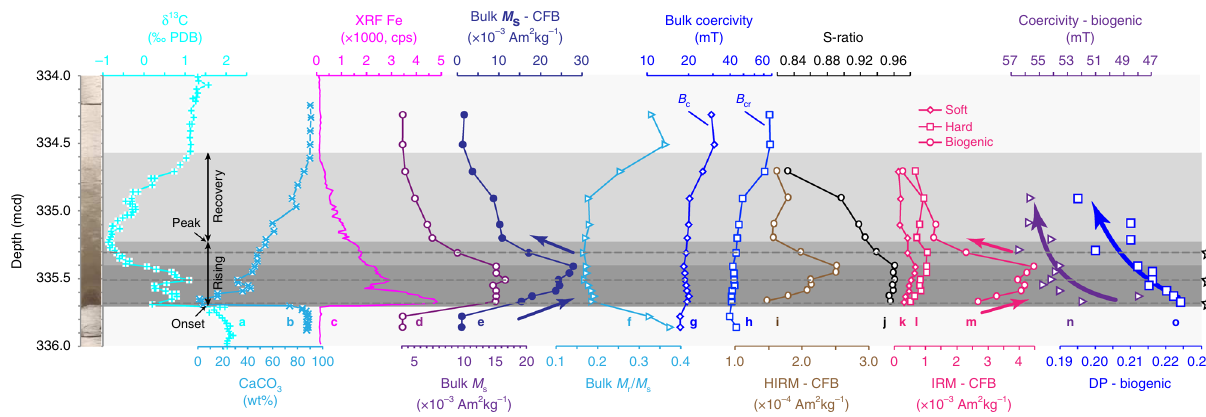
Fig. 3 Down-core magnetic pro fi les for 16 discrete samples across the PETM for ODP Hole 1263C. a – c Published bulk sediment carbon isotope, carbonate content, and Fe concentration (X-ray fl uorescence measurements) 4 . d , e Bulk M s , f M rs / M s , g bulk coercivity, h bulk coercivity of remanence, i hard IRM plotted on a carbonate-free basis (HIRM-CFB), j S-ratio, k – m IRM-CFB coercivity components, n fi tted B 1/2 and o DP values for the biogenic magnetite component from IRM curves. Left: Core photo of the PETM interval in Hole 1263C 40 . Horizontal dashed lines and stars indicate positions of the three samples with magnetic properties presented in Fig. 2, and detailed TEM observations presented in Fig. 4. Grey bars mark different stages across the PETM. Arrows in e , m , n , o are visual guides for data